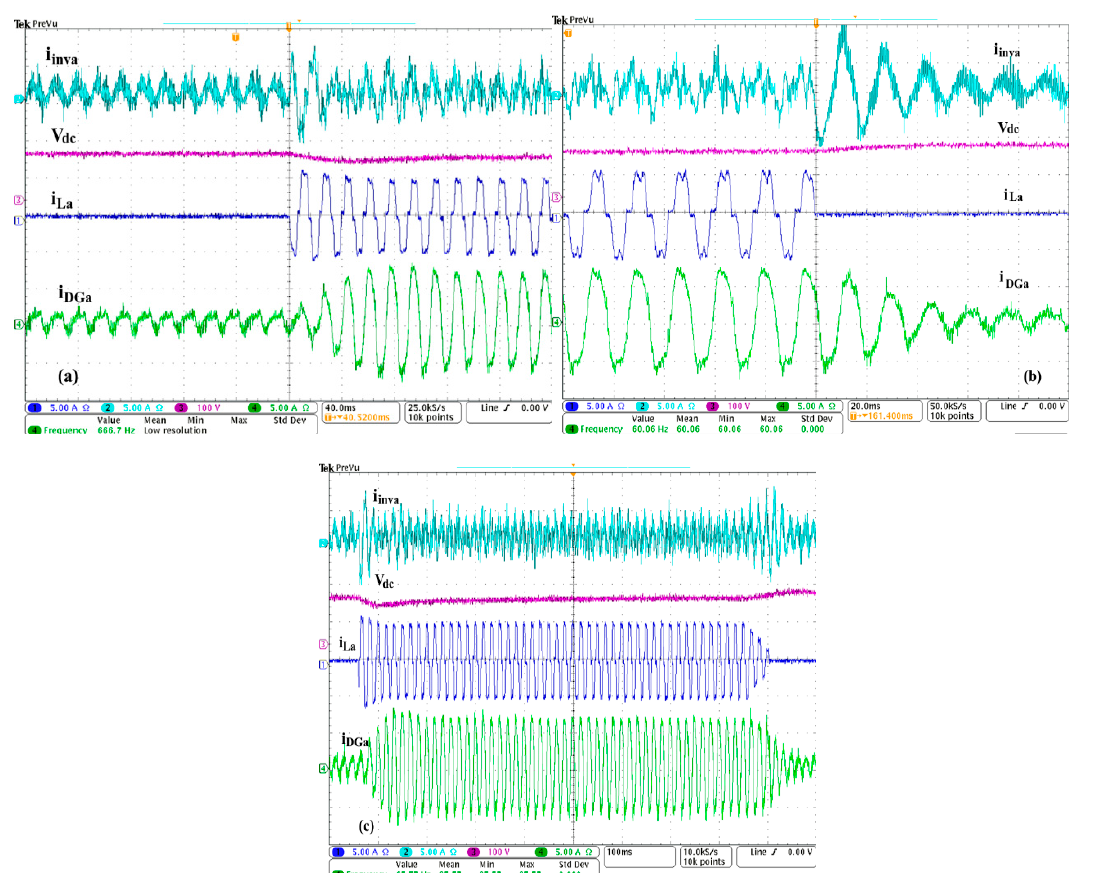
Figure 21. Experimental results during the presence of ( a , b ) balanced nonlinear load, and ( c ) sudden connected and disconnected of the load.